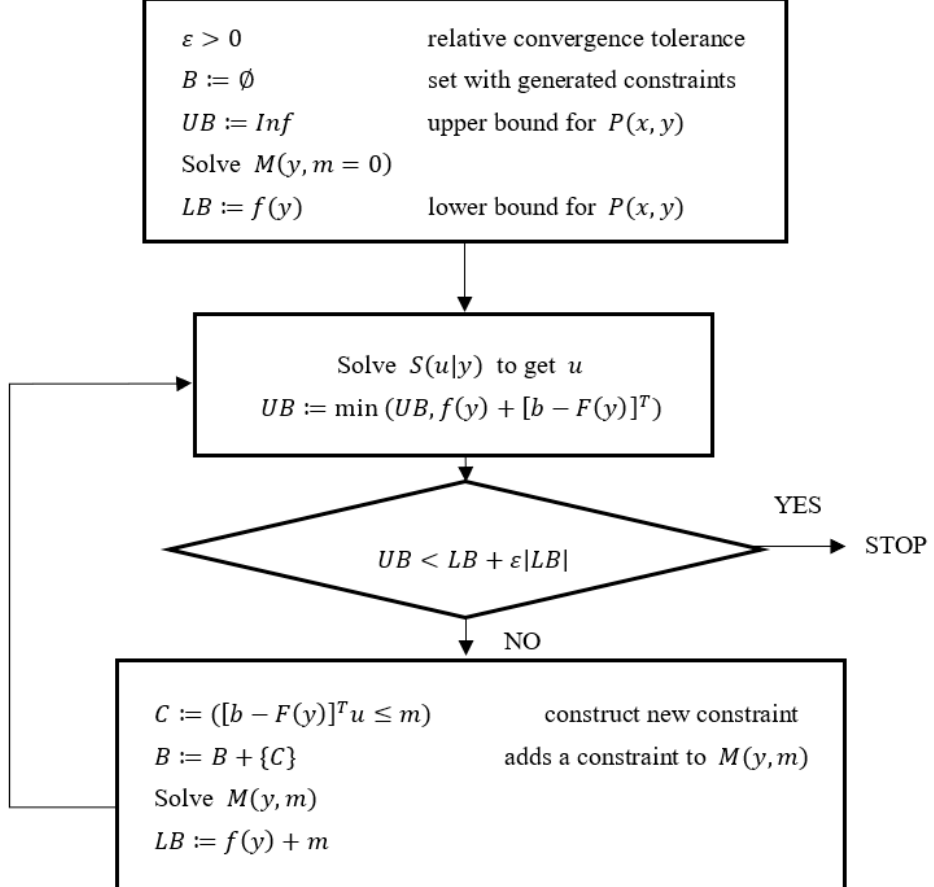
Figure 3. Benders decomposition algorithm flowchart [12].